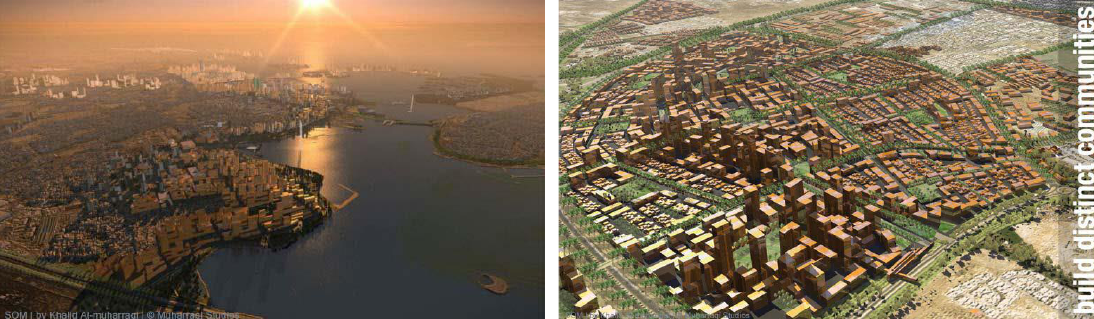
Figure 13: 2030 Bahrain National Planning Development Strategy. Manama .